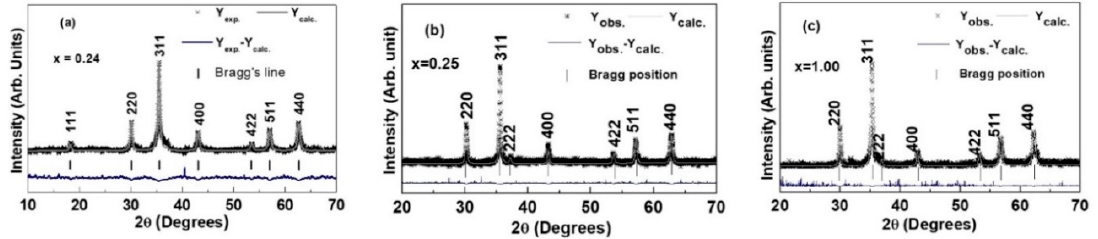
Figure 1. Rietveld-refined XRD patterns of: ( a ) dry gel Co 0.76 Zn 0.24 Fe 2 O 4 , ( b ) Li 0.375 Zn 0.25 Fe 2.375 O 4 annealed at 450 °C/3 h, ( c ) ZnFe 2 O 4 annealed at 450 °C/3 h.